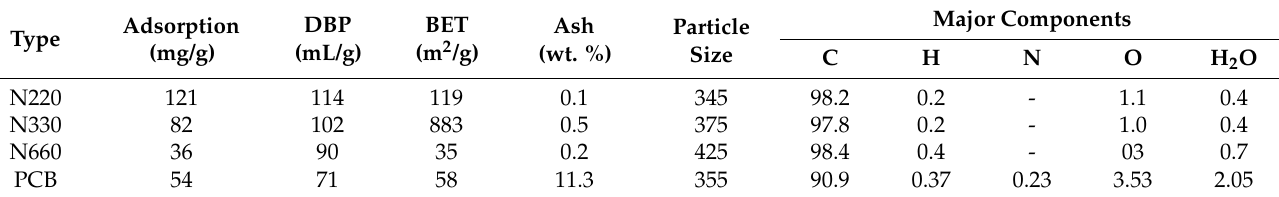
Figure 1. Tire pyrolysis oil and pyrolysis carbon black. Table 2. The major characteristics of pyrolysis carbon black. Table 2. The major characteristics of pyrolysis carbon black.